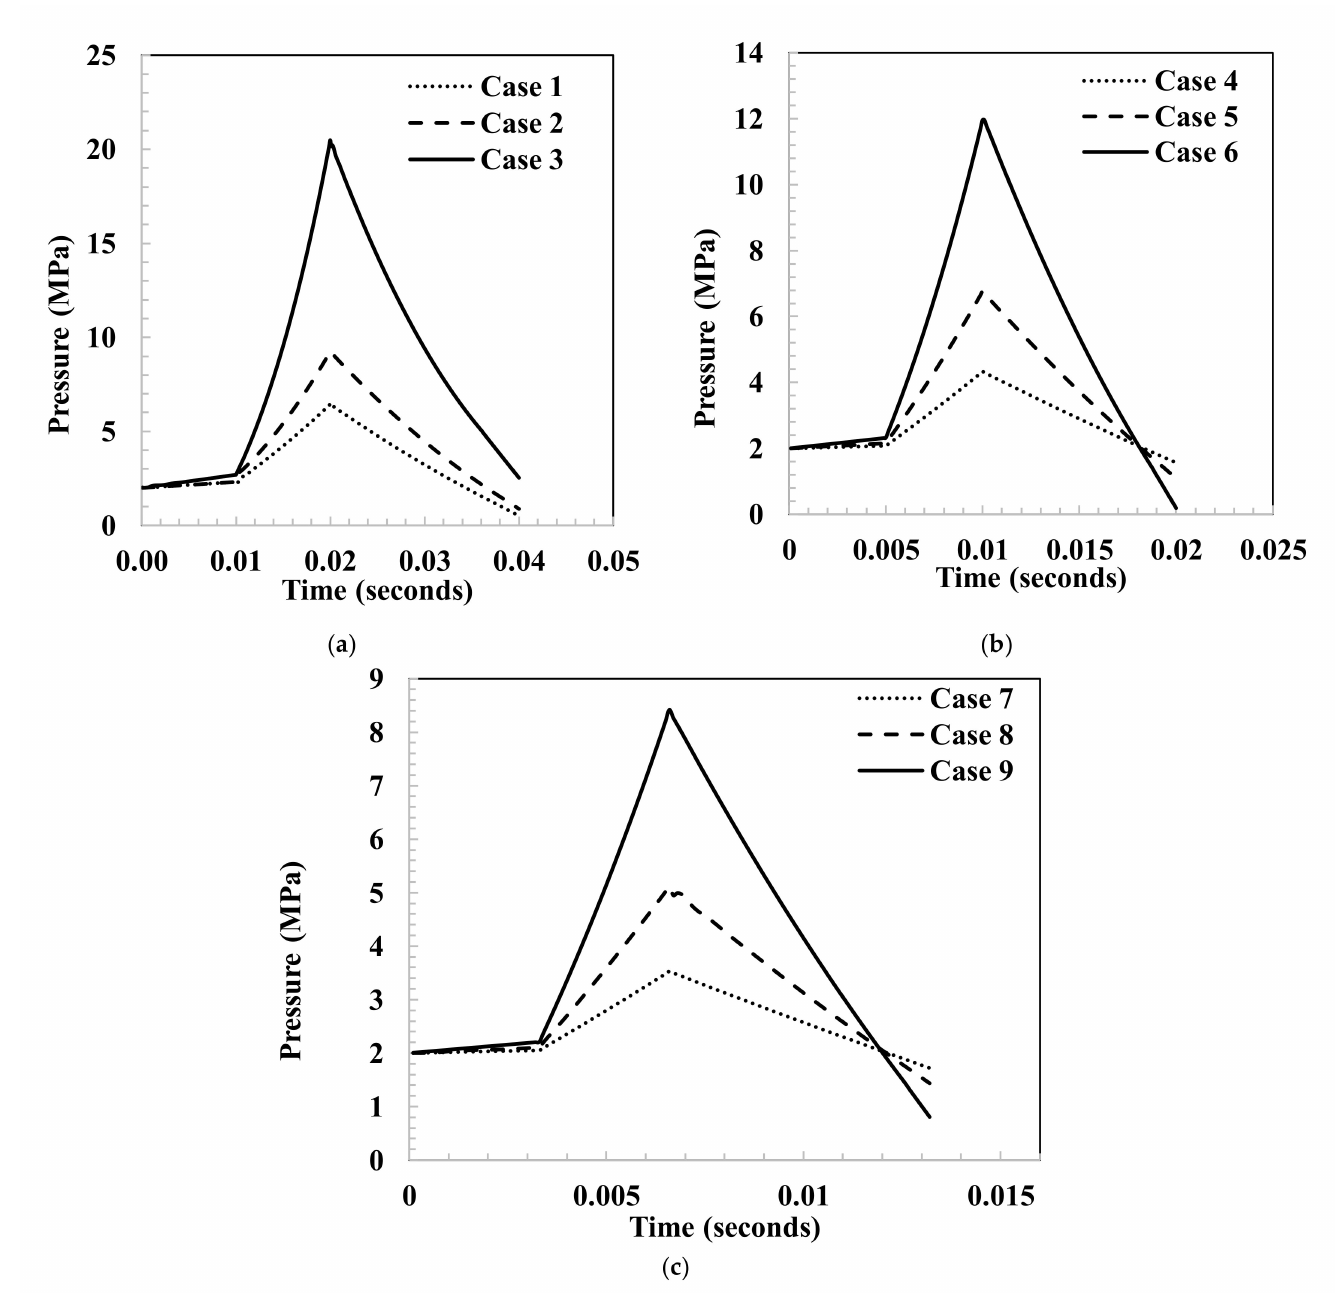
Figure 5. Average Internal Pressure at ( a ) 1500 RPM, ( b ) 3000 RPM and ( c ) 4500